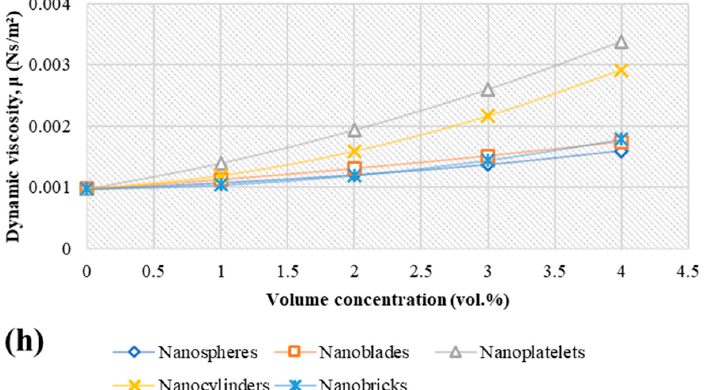
Figure 5. Thermal conductivity and dynamic viscosity for different metal oxide nanostructures and different nanoparticles shape at 20 nm and 293 K; ( a ) k-Al 2 O 3 , ( b ) µ-Al 2 O 3 , ( c ) k-CuO, ( d ) µ-CuO, ( e ) k-SiO 2 , ( f ) µ-SiO 2 , ( g ) k-ZnO, ( h ) µ-ZnO.